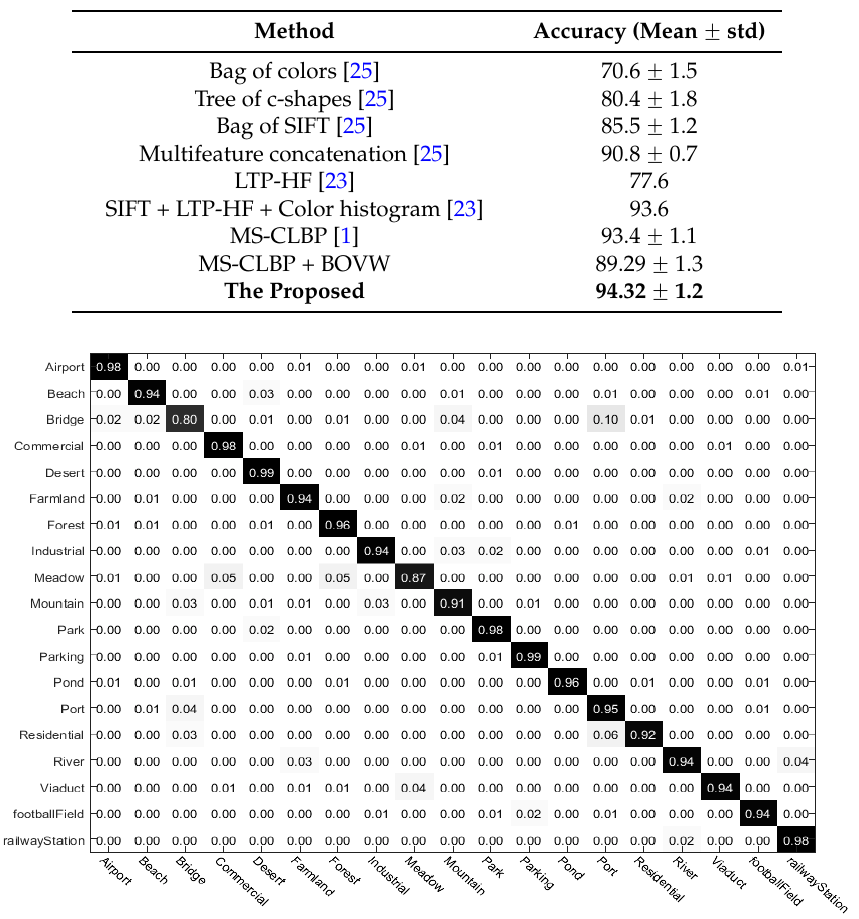
Table 2. Comparison of classification accuracy (%) for the 19-class satellite scene dataset.